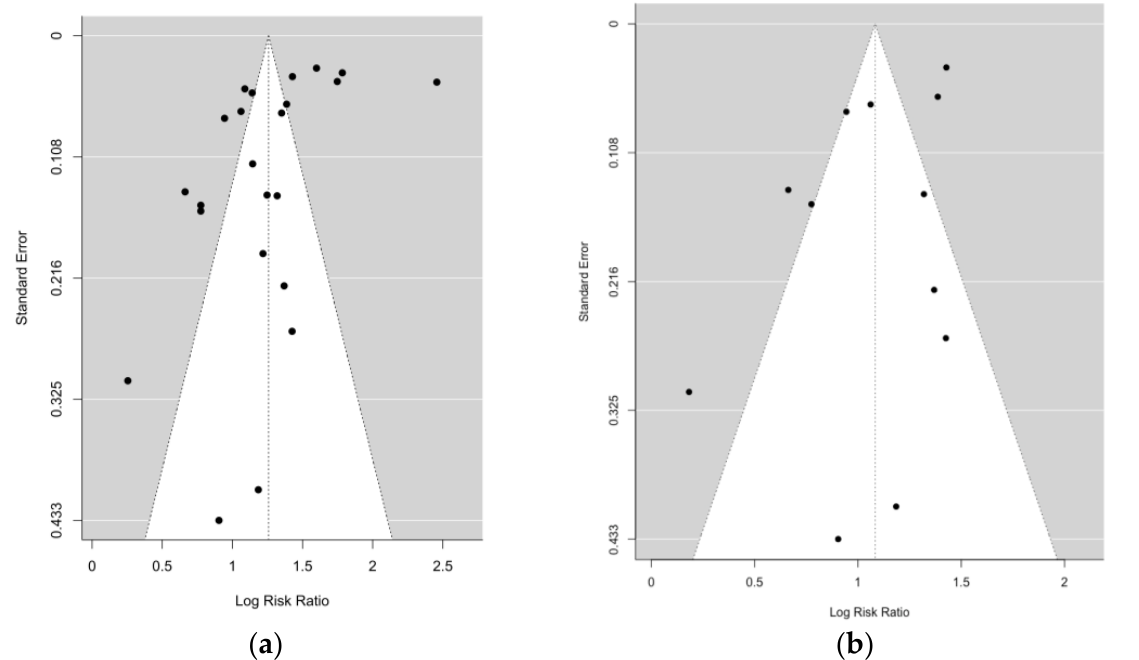
Figure A1. ( a ) Funnel plot for random effects meta-analysis including 23 risk estimates of suicide in lung cancer patients. p -value for Begg’s test = 0.7147; p -value for Egger’s test = 0.0214. ( b ) Funnel plot for random effects meta-analysis including 12 risk estimates of suicide in lung cancer patients. p -value for Begg’s test = 0.6384; p -value for Egger’s test =